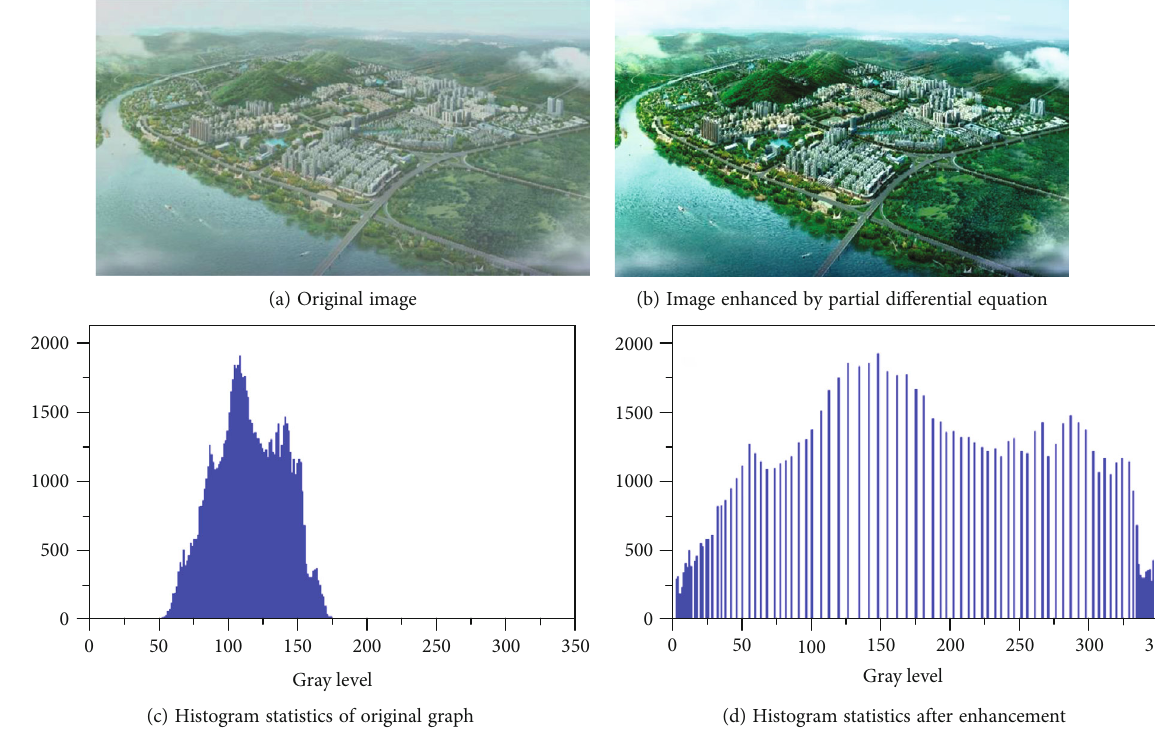
Figure 1: Comparison between original image and enhanced